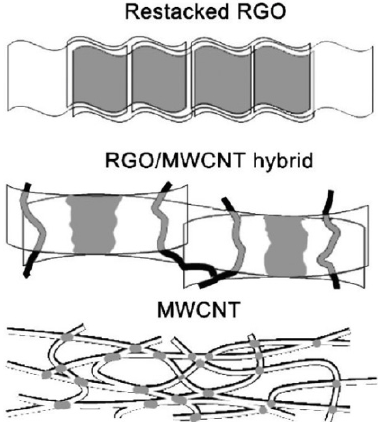
Figure 4. Schematic of how the restacking factor of the graphene layers is blocked when the CNTs are inserted into the composite electrode. Reproduced from [30] with permission from John Wiley and Sons. Copyright 2012.